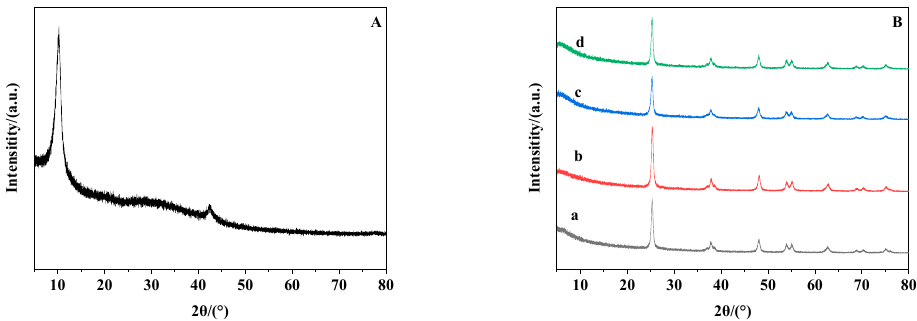
Figure 4. The x-ray diffractometry (XRD) spectra of ( A) graphene oxide and ( B ): ( a ) TiO 2 /PVDF membrane; ( b ) NT/PVDF membrane; ( c ) TG/PVDF membrane and ( d ) NTG/PVDF membrane.